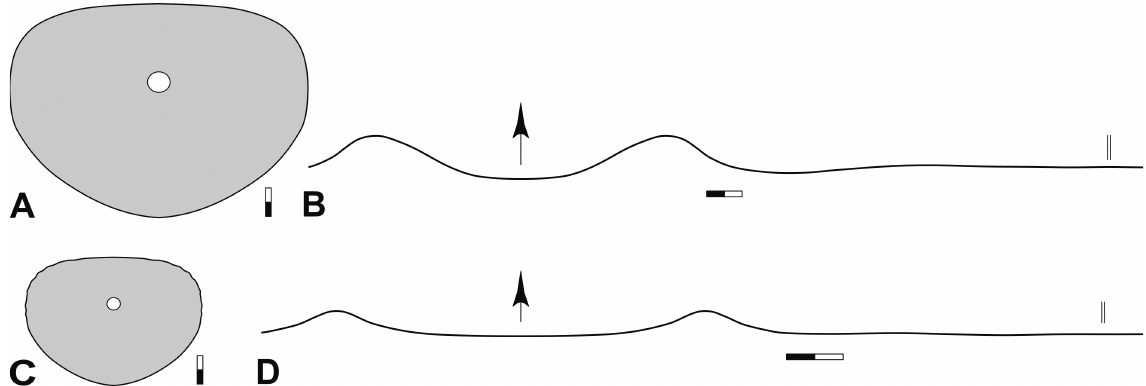
Fig. 5. Rineceras tenerum sp. nov., holotype MB.C.30440.1 (Korn et al . 2002 Coll.) from Oued Temertasset. A . Whorl profile of the larger segment. B . Suture line, at ww = 19.7 mm, wh = 13.7 mm. C . Whorl profile of the smaller segment. D . Suture line, at dm = 26.3 mm, ww = 11.3 mm, wh = 8.0 mm. Scale bar units = 1 mm.